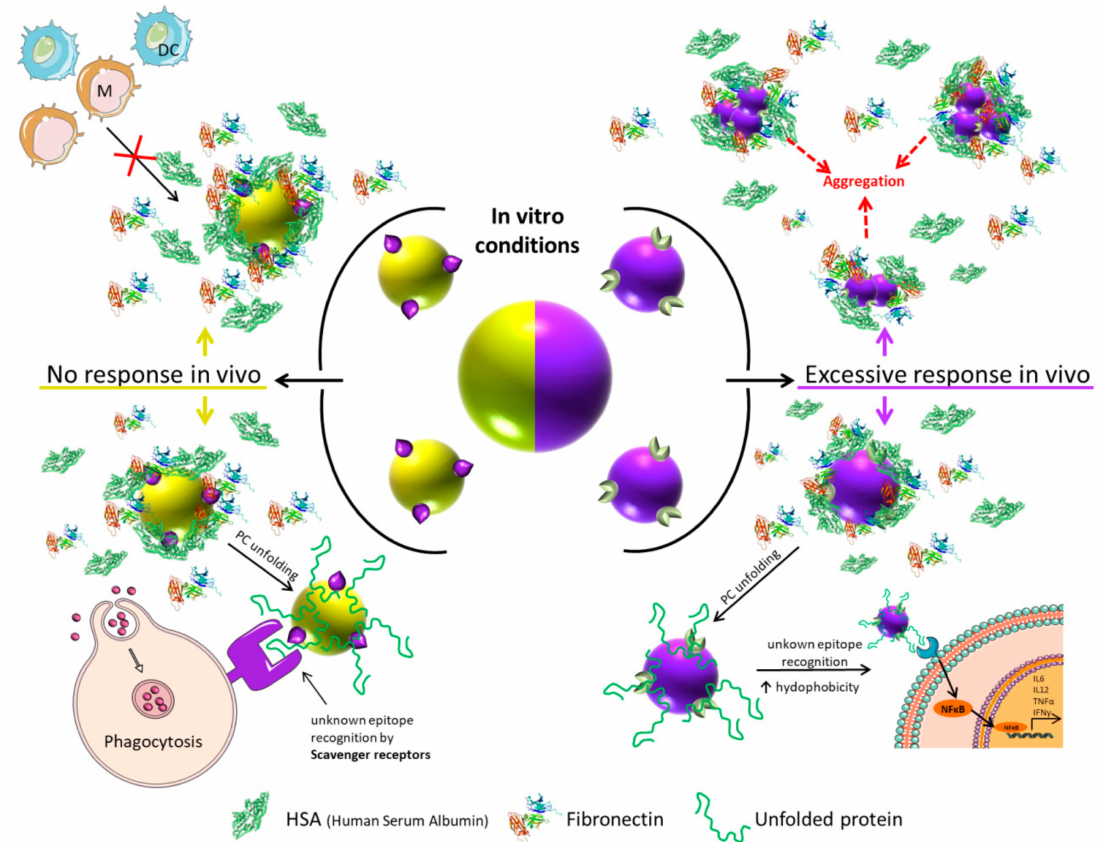
Figure 2. Nanoparticle-based immunotherapy failure because of protein corona (PC) formation. No-response ( left ) vs. excessive or uncontrolled response ( right ). Top left panel: Immune cells are not able to recognize the molecules on the surface of the NPs because the PC covers the NPs partially or totally. Bottom left: NP phagocytosis by macrophages because of the denaturalization of the proteins (in green) on the surface of the NPs. Top right: Aggregation of NPs triggers toxic e ff ects by strange-body recognition by immune system. Bottom right: Nuclear Factor κ B (NF- κ B) translocation to the nucleus because of the recognition of denatured proteins on the surface of the